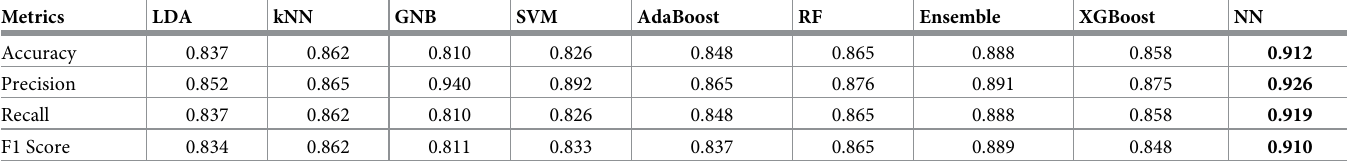
Table 7. Classification accuracy obtained using all features. Metrics Accuracy Precision Recall